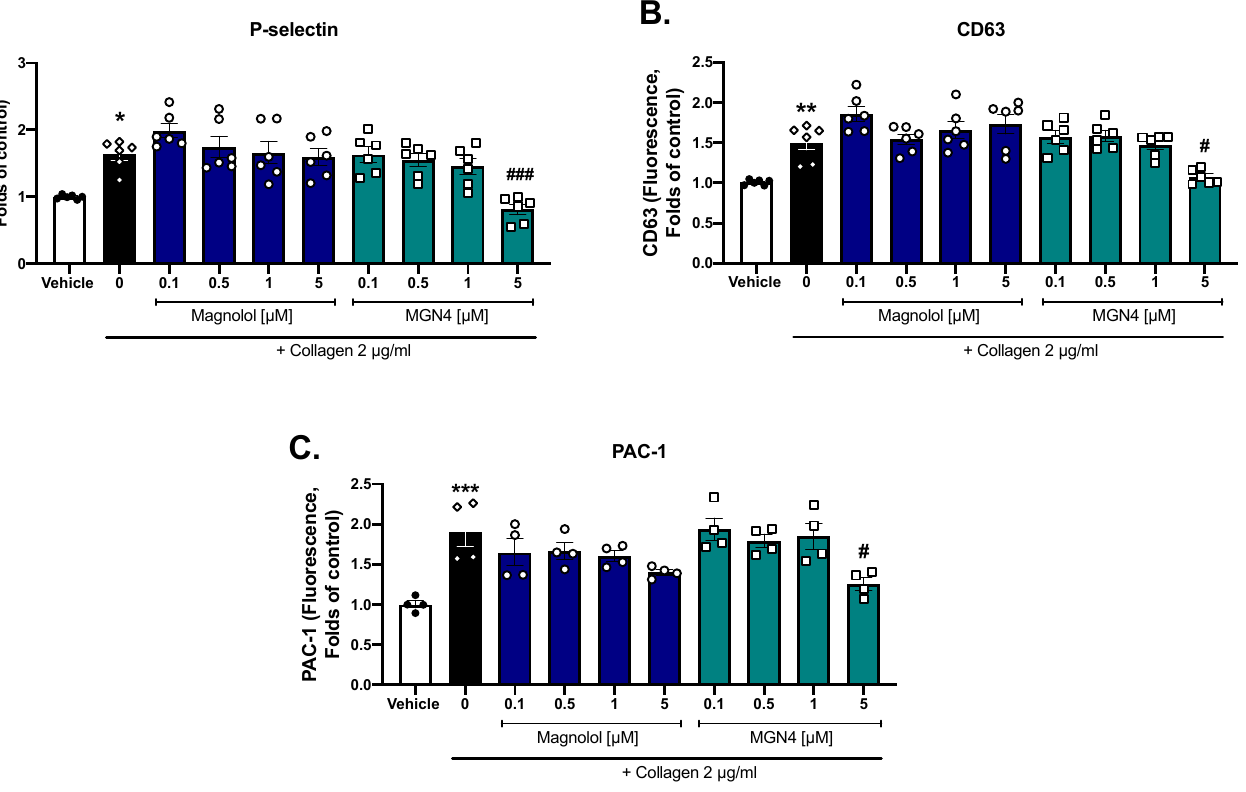
Figure 3. Effect of magnolol and MGN4 on platelet activation markers. ( A ) P-selectin expression. ( B ) CD63 expression. ( C ) GP IIb/IIIa activated (PAC-1) expression. Platelets were identified as the CD61 positive population and these CD61-expressing cells were analyzed in terms of change in mean fluorescence intensity than the vehicle. The results were obtained from at least four independent donors and bars represent the mean ± SEM. Vehicle: DMSO 0.4%. The statistical analysis was performed using a one-way analysis of variance (ANOVA) and the Bonferroni post hoc test. * p < 0.05 ** p < 0.01 and *** p < 0.001 vs vehicle; # p < 0.05 and ### p < 0.001 vs. activated control.